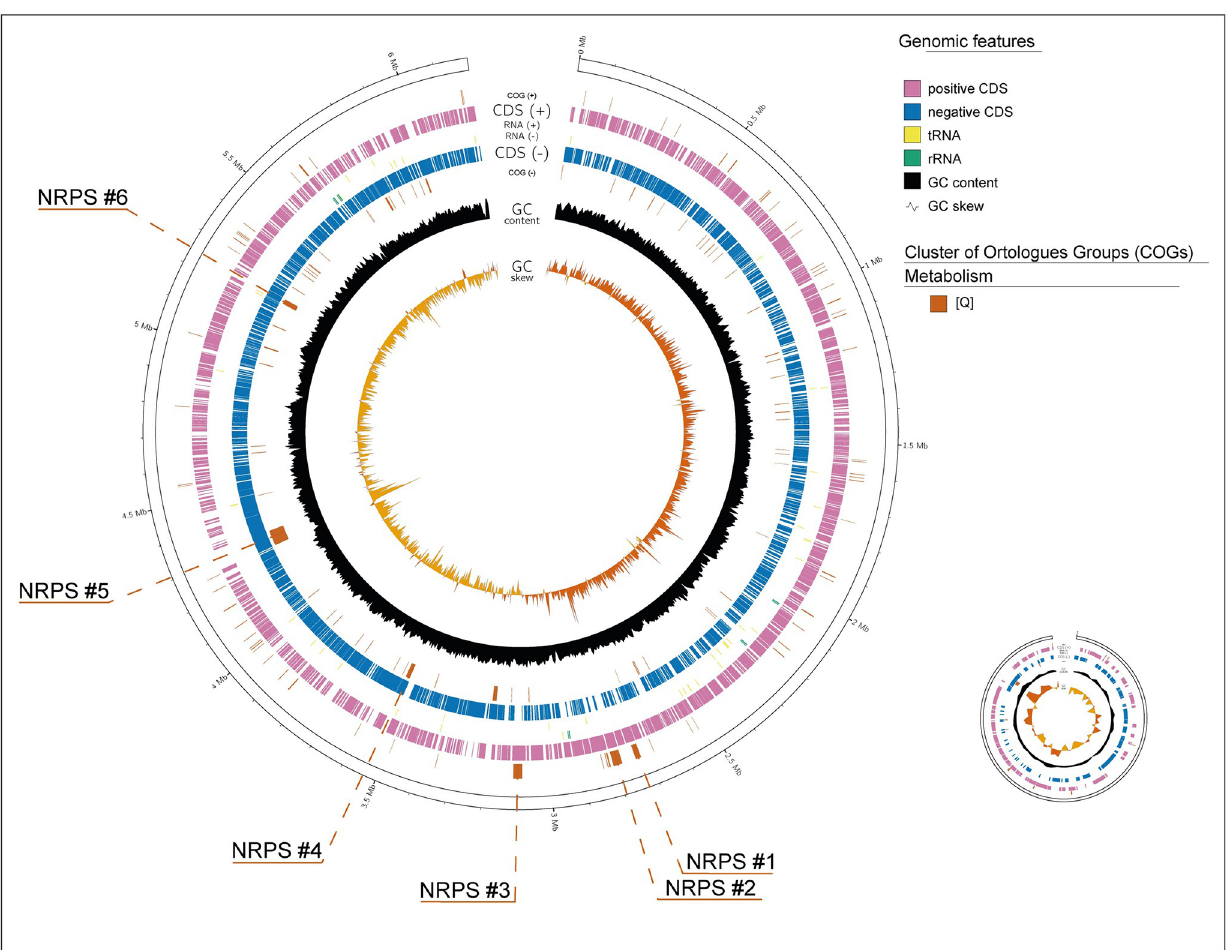
Fig 4. Visualization of NRPS biosynthetic gene clusters within the genome of Rhodococcus sp. H-CA8f. Genovi representation of Rhodococcus sp. H-CA8f complete genome is depicted with an interior break in the ideogram to easily identify each track ( -s complete , -cs dawn , —cogs Q , -te ). Selection of Q orthologs (Secondary metabolites biosynthesis, transport, and metabolism) within the H-CA8f genome includes NPRS CDSs and can be easily seen by the whole genome